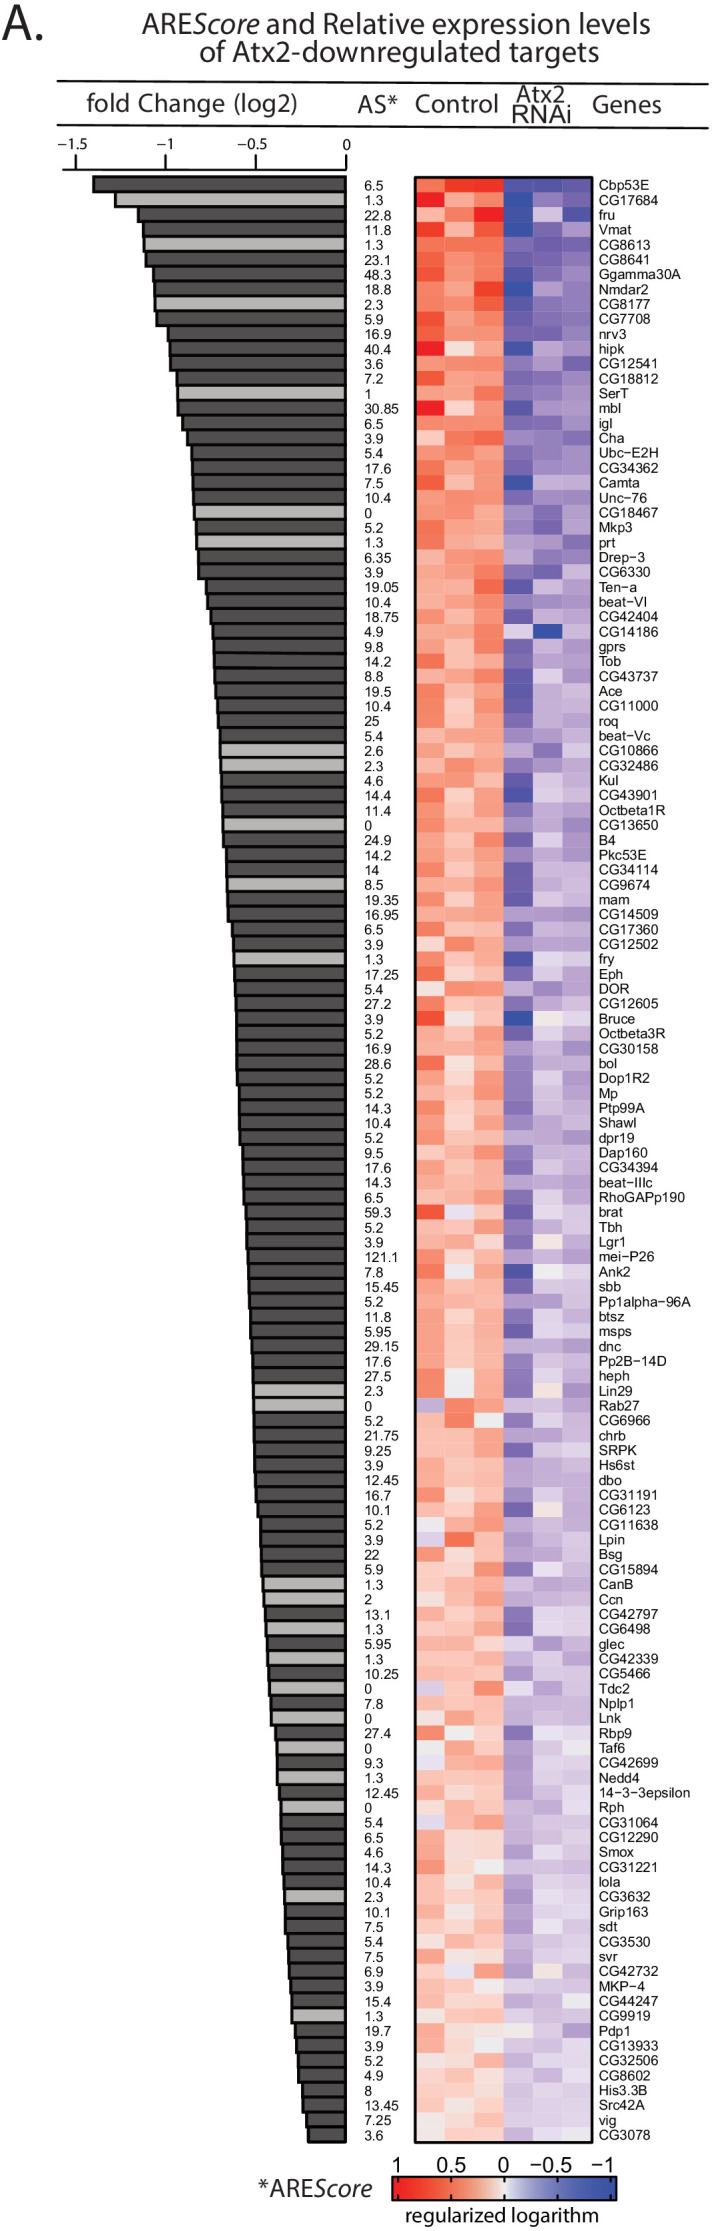
Correlation between AREScore and relative expression levels of Atx2-downregulated targets for three biological replicates (selected based on a p-value<0.05).Heatmap indicates relative expression levels for each mRNA in control and experimental brain samples. Light gray bars represent Atx2-target mRNAs without significant AREScore.